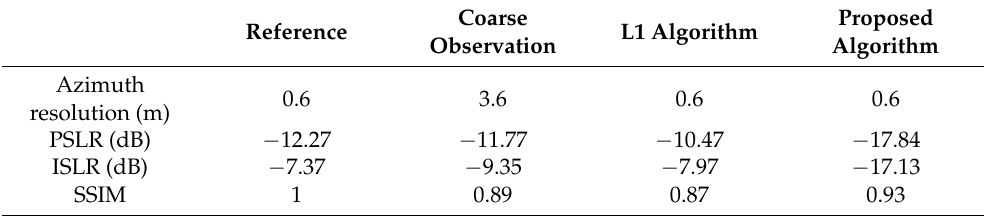
Table 7. Evaluation results.